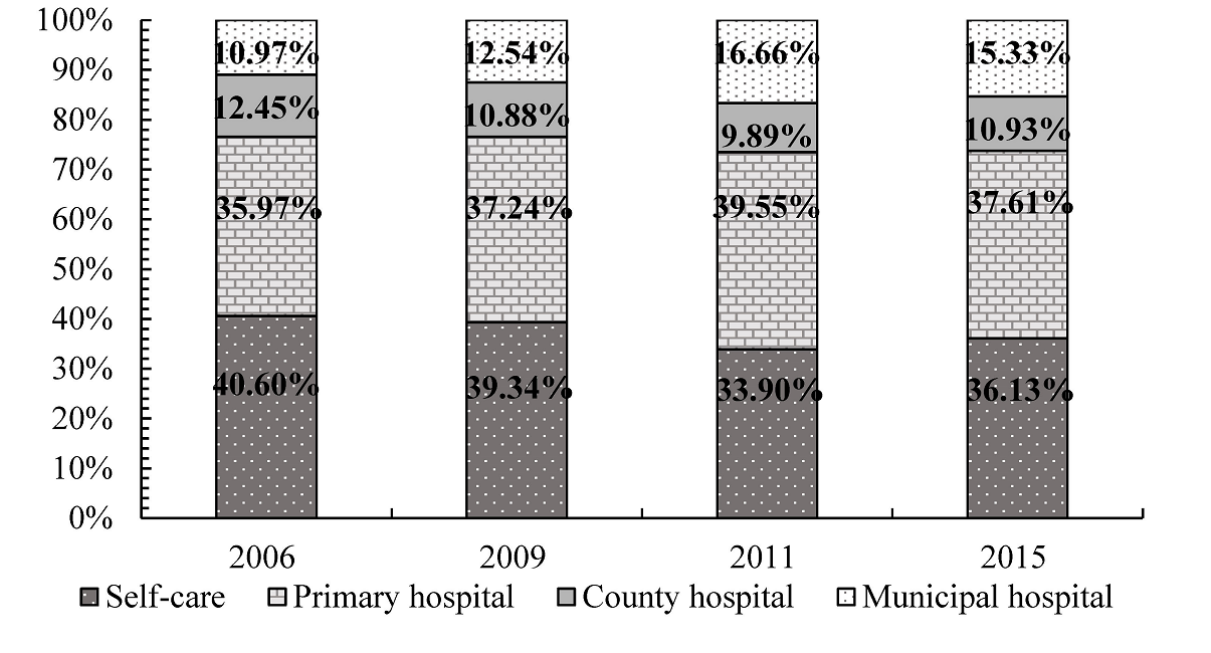
Figure 1. Health care provider choices of Chinese adult residents from 2006 to